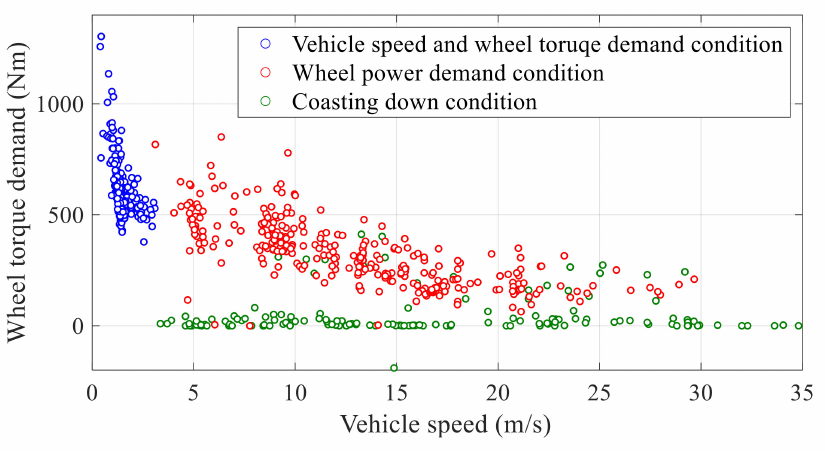
Figure 9. “Engine on” Conditions with Filters